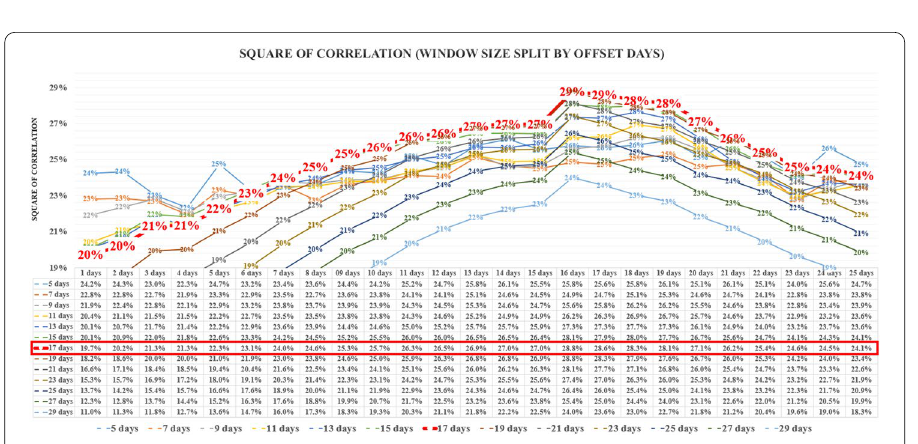
Fig. 5 Square of correlation by window size split by offset